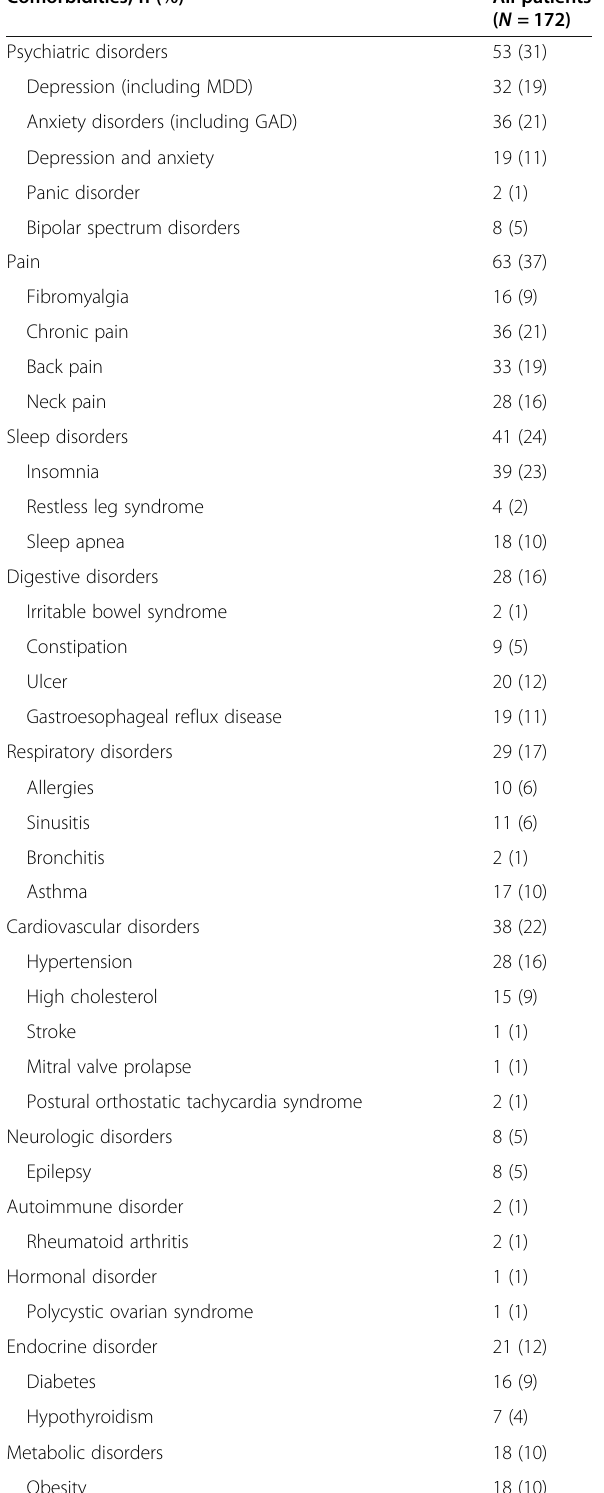
Table 3 Patient-reported improvement, headache frequency, and migraine pain intensity